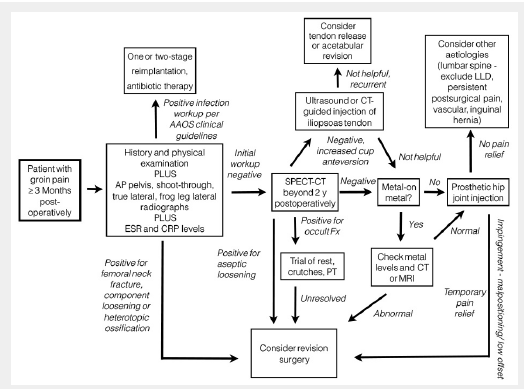
Diagnostic algorithm for groin pain after total hip replacement [93, 94]. AAOS = American Academy of Orthopedic Surgeons; AP = anteroposterior; CRP = C-reactive protein; CT = computed tomography; ESR = erythrocyte sedimentation rate; LLD = leg- length discrepancy; MRI = magnetic resonance imaging; PT = physiotherapy; SPECT = single photon positron emission computed